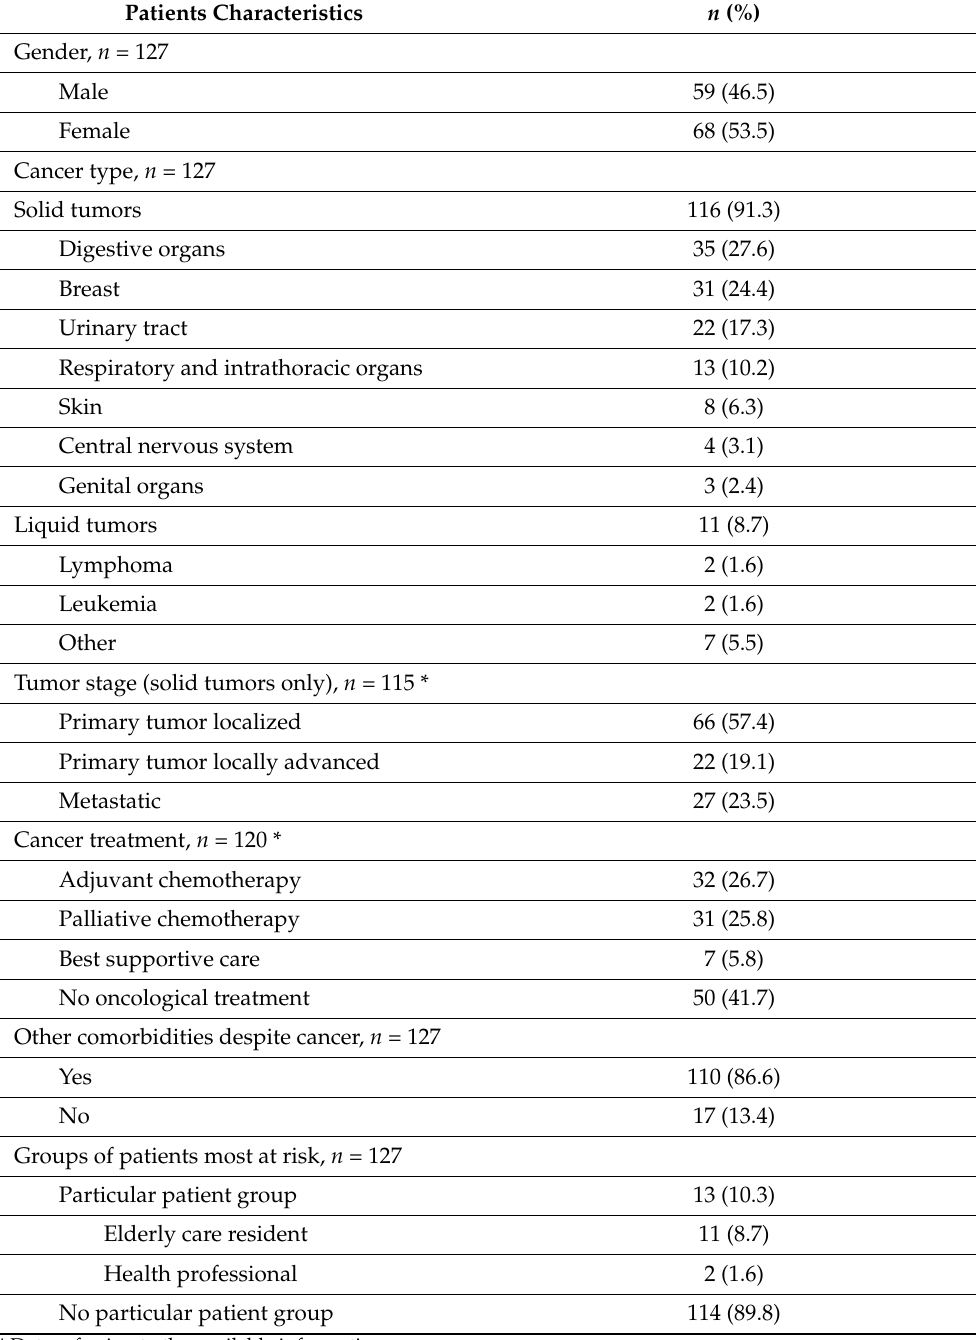
Table 1. Clinicopathological characteristics of cancer patients with SARS-CoV-2